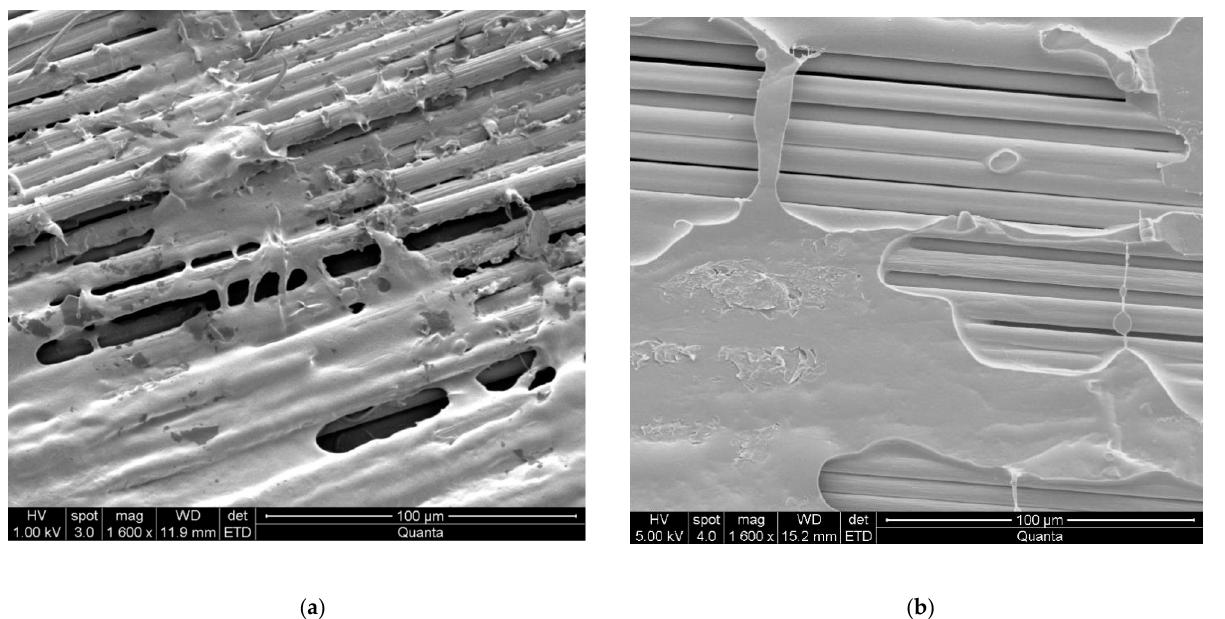
Figure 13. ( a ) SEM imaging of the weld consolidated via ultrasonic welding, ( b ) compared with the weld following thermo-compressive consolidation.